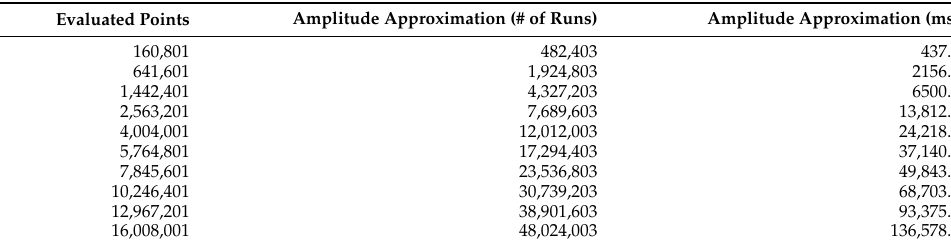
Table A1. Reference measurement results without pre-filtering with 3 receivers.